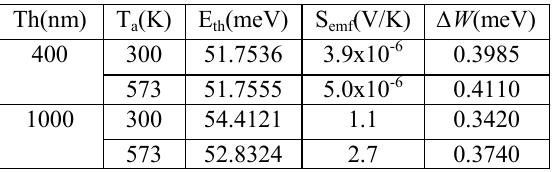
Table 1: Values of E deposited CdTe film and annealed at 573K with 400and 100nm